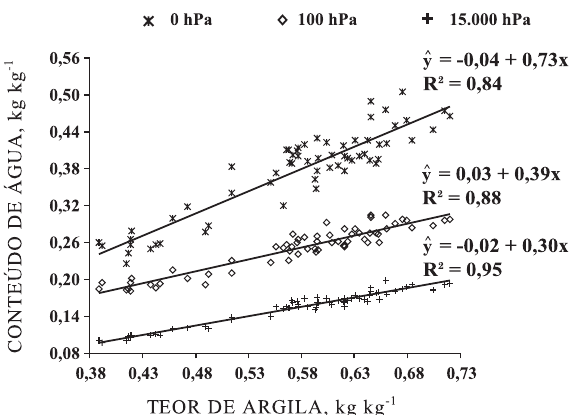
Figura 1. Relação entre o teor de argila do solo e o conteúdo de água retida no solo Latossolo Vermelho eutrófico típico nas tensões de 0, 100 e 15.000